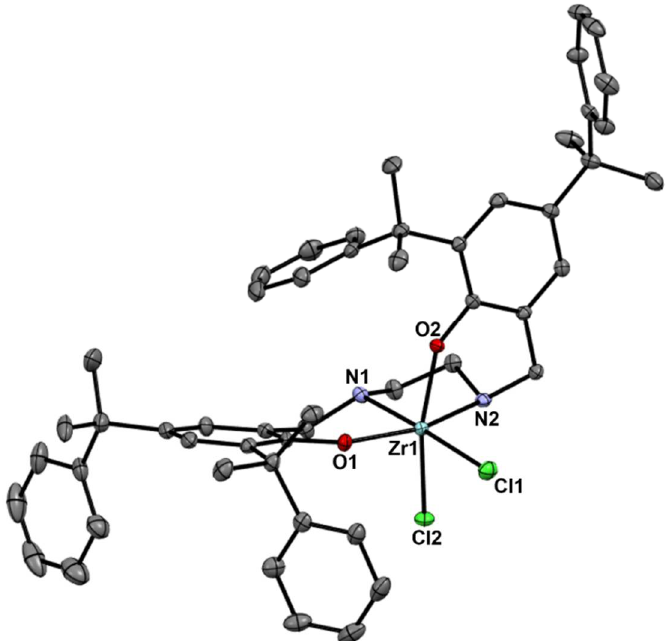
Figure 1. ORTEP diagram of [(H 2 N 2 O 2 )ZrCl 2 ], 2 , showing thermal ellipsoids at a 40% probability level. Hydrogen atoms and the co-crystalized diethyl ether molecule were omitted for clarity. The selected bond lengths (Å) and angles ( ◦ ) are: Zr(1)-N(1) 2.369(2), Zr(1)-N(2) 2.326(2), Zr(1)-O(1) 1.945(2), Zr(1)-O(2) 1.979(2), Zr(1)-Cl(1) 2.4534(6), Zr(1)-Cl(2) 2.4902(6); N(1)-Zr(1)-N(2) 74.39(7), N(1)-Zr(1)-O(1) 78.32(6), N(2)-Zr(1)-Cl(1) 102.81(5), O(1)-Zr(1)-Cl(1) 104.17(5), O(2)-Zr(1)-Cl(2) 155.90(5).